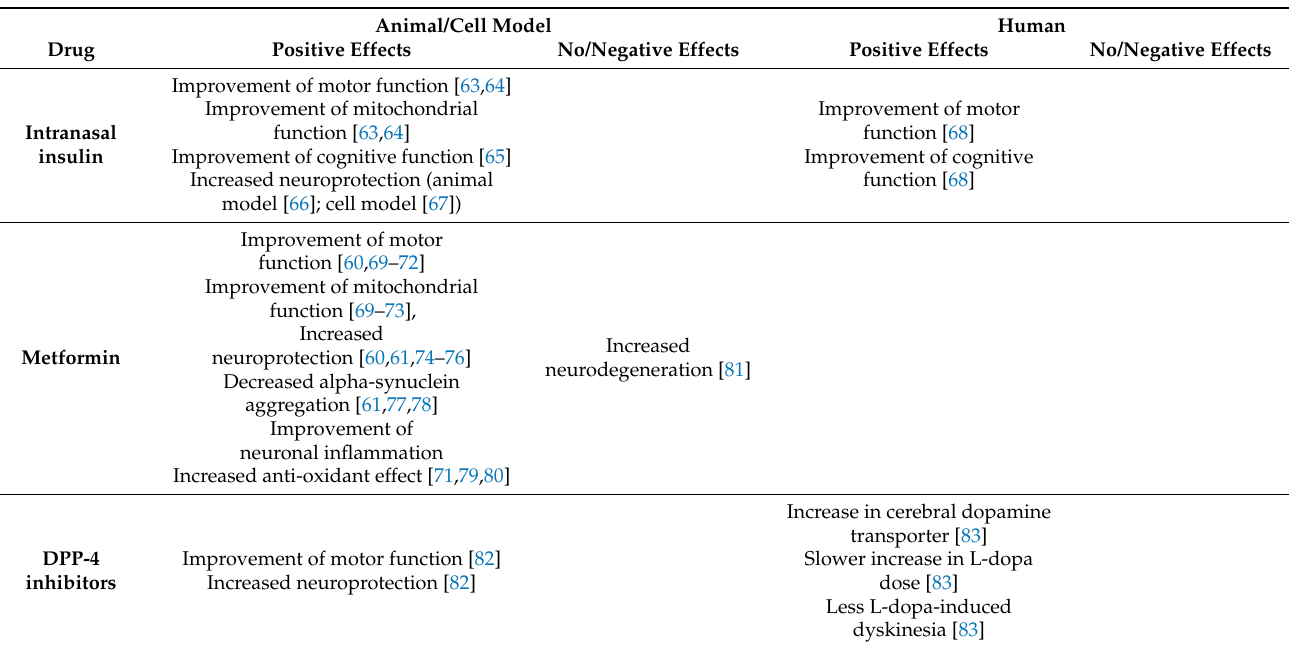
Table 1. Effects of antidiabetics on